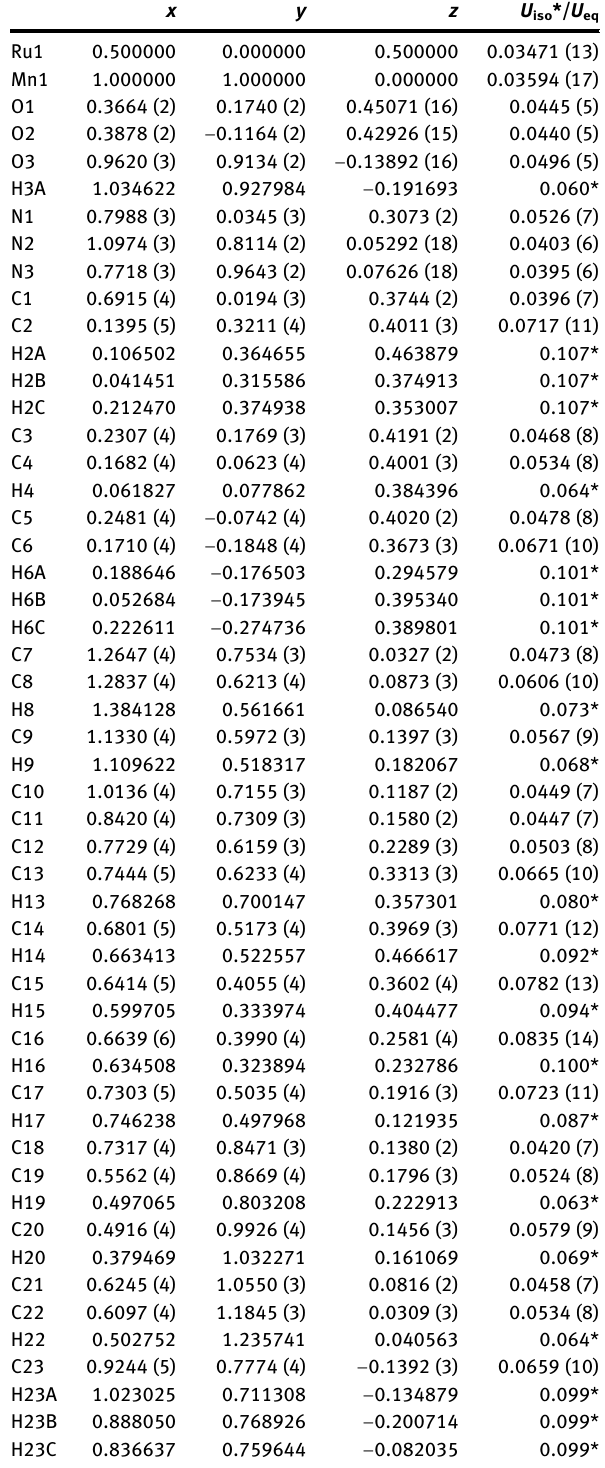
Table  : Fractional atomic coordinates and isotropic or equivalent isotropic displacement parameters (Å 